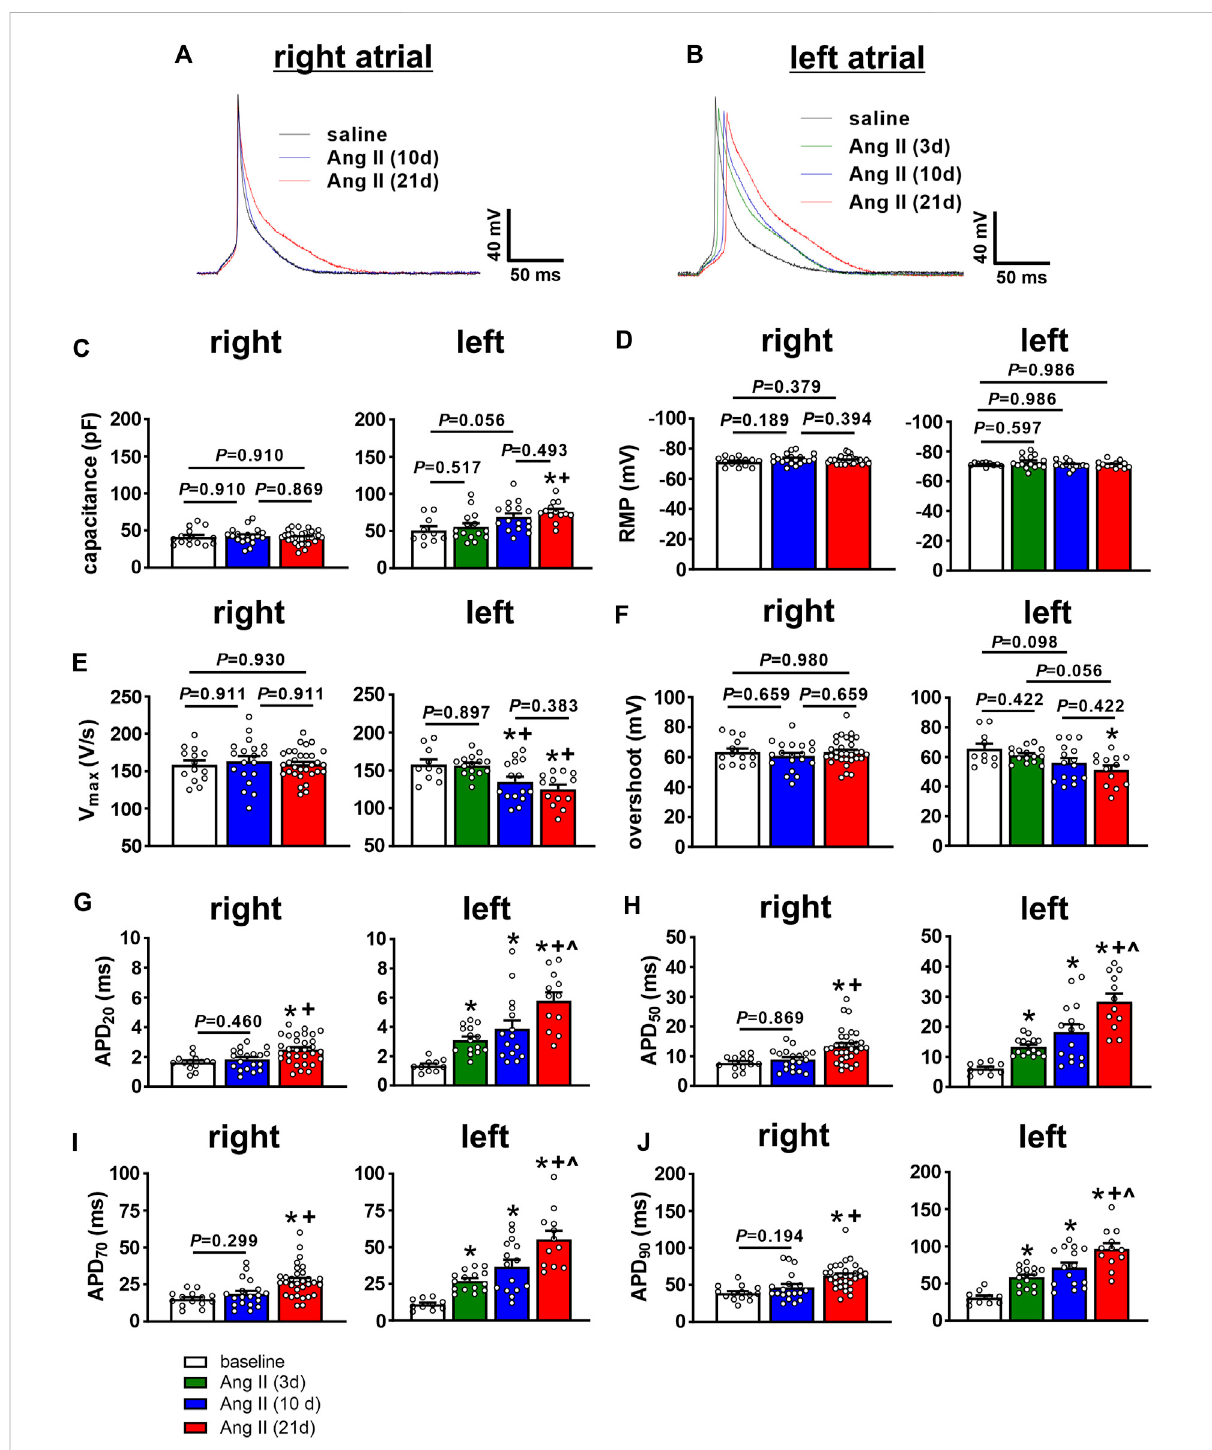
FIGURE 4 Time course of the effects of Ang II on right and left atrial AP morphology. (A) Representative APs in isolated right atrial myocytes from mice infused with saline for 21 days or Ang II for 10 and 21 days. (B) Representative APs in isolated left atrial myocytes from mice infused with saline for 21 days or Ang II for 3, 10 and 21 days. (C – J) Summary of cell capacitance (C) , resting membrane potential (RMP, (D) , AP upstroke velocity (V max , (E) , AP overshoot (F) , AP duration at 20% repolarization (APD 20 , (G) , APD 50 (H) , APD 70 (I) and APD 90 (J) in right and left atrial myocytes from mice infusedwithsalineorAngIIforthespeci fi eddurations.* p < 0.05vssaline, + p < 0.05vsAngII(3 days), ^ p < 0.05vsAngII(10 days)byone-wayANOVA with a Holm-Sidak posthoc test. For right atrial myocytes, n =14 for saline, 19 for Ang II (10 days) and 31 for Ang II (21 days). For left atrial myocytes, n =10 for saline, 15 for Ang II (3 days), 16 for Ang II (10 days) and 13 for Ang II (21